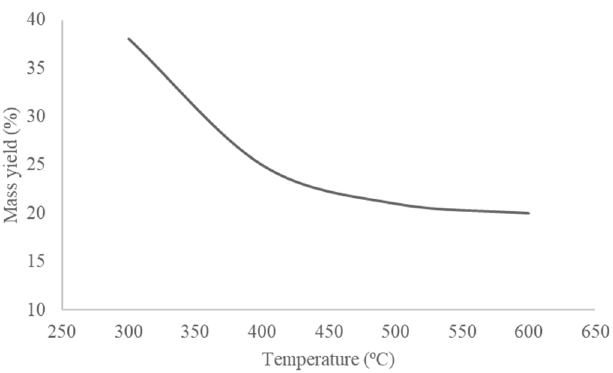
Figure 6. Mass yield curve for a temperature range between 300 °C and 600 °C for pine biomass.